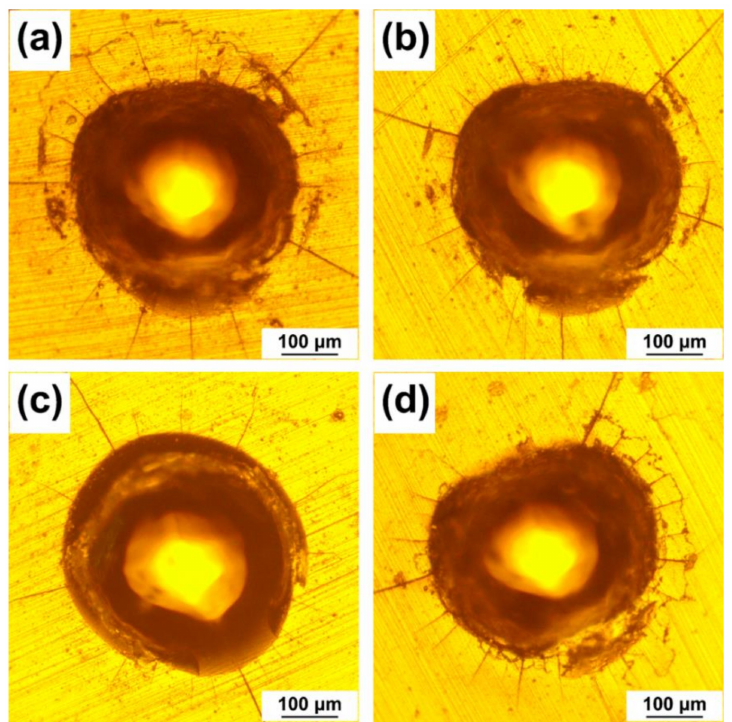
Figure 11. Rockwell indentation images made with 150 kg load for 15 s in Cr 2 N/TiN coatings deposited by various V s ( a ) − 30 V, ( b ) − 60 V, ( c ) − 100 V, and ( d ) − 150